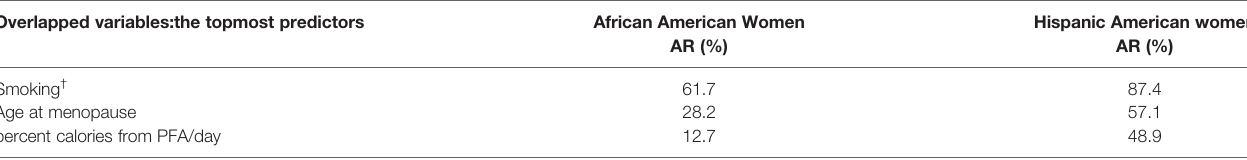
TABLE 4 | Colorectal cancer attributable risk for the lifestyle factors detected as the topmost predictive variables in both African American and Hispanic American women. Overlapped variables:the topmost predictors